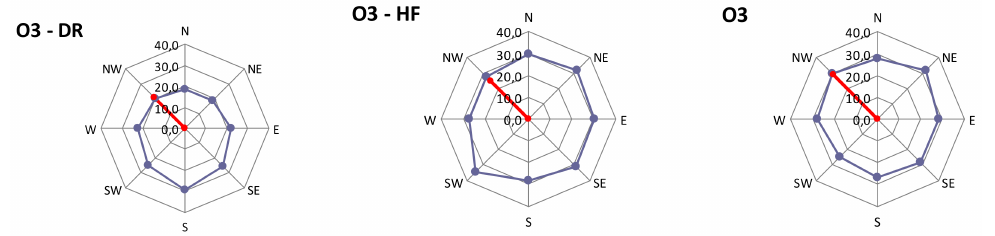
Figure A3. Average levels of O 3 vs. wind direction measured at the Stary Wiec station during drilling (DR), hydrofracturing (HF), and for the remaining period of measurements. All concentration units are in parts per billion (ppb). The red bars indicate the airmass coming directly from the area of the wells.